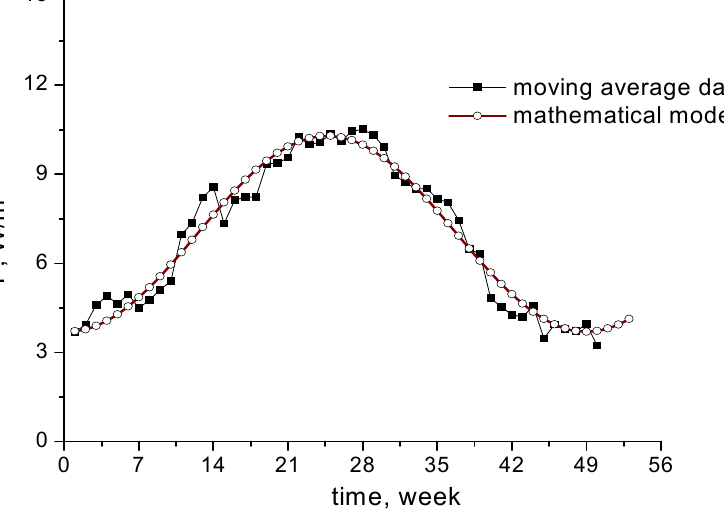
Figure 6. Comparison between weekly moving average data and the mathematical model.